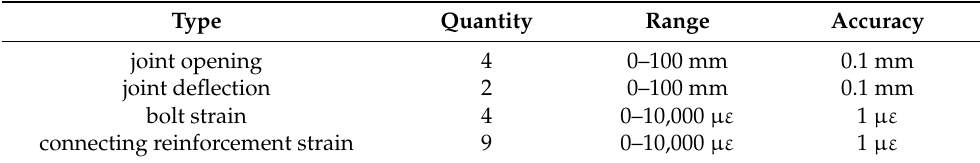
Table 1. List of measurement points.